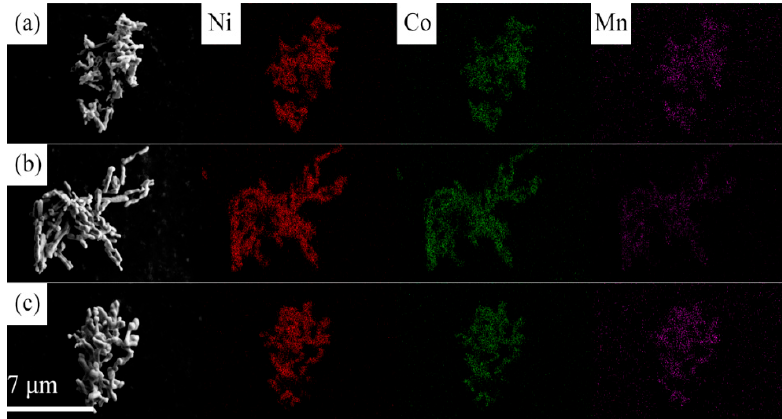
Figure 5. EDX mapping images of ( a ) NCM750, ( b ) NCM800, and ( c ) NCM850.